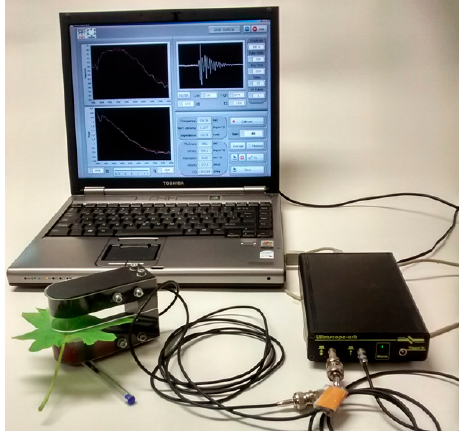
Figure 8. Example of NC-RUS system realization for Vitis vinifera leaves.